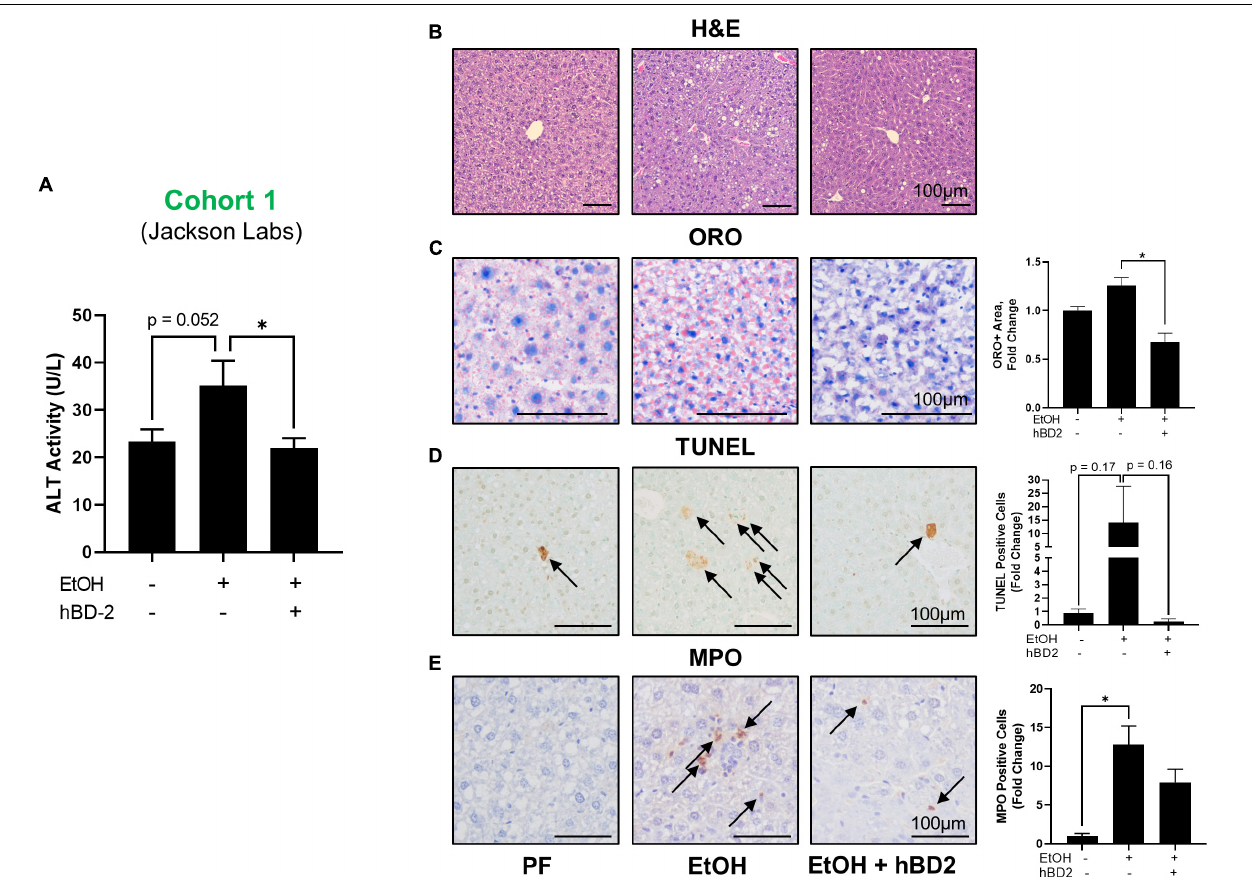
FIGURE 2 | Human beta defensin 2 ameliorated liver injury in Cohort 1. (A) ALT activity levels. (B–E) Representative digital micrographs of H&E-stained liver sections, ORO-stained liver sections, TUNEL-stained liver sections, and MPO immunohistochemistry with quantitation of ORO+ area, TUNEL+ cells, and MPO+ neutrophils shown to the right. H&E images were captured at 100 × magnification; all other images were captured at 200 × magnification. Scale bar represents 100 µ m in each panel. Data are reported as mean ± standard error of the mean. * p < 0.05.